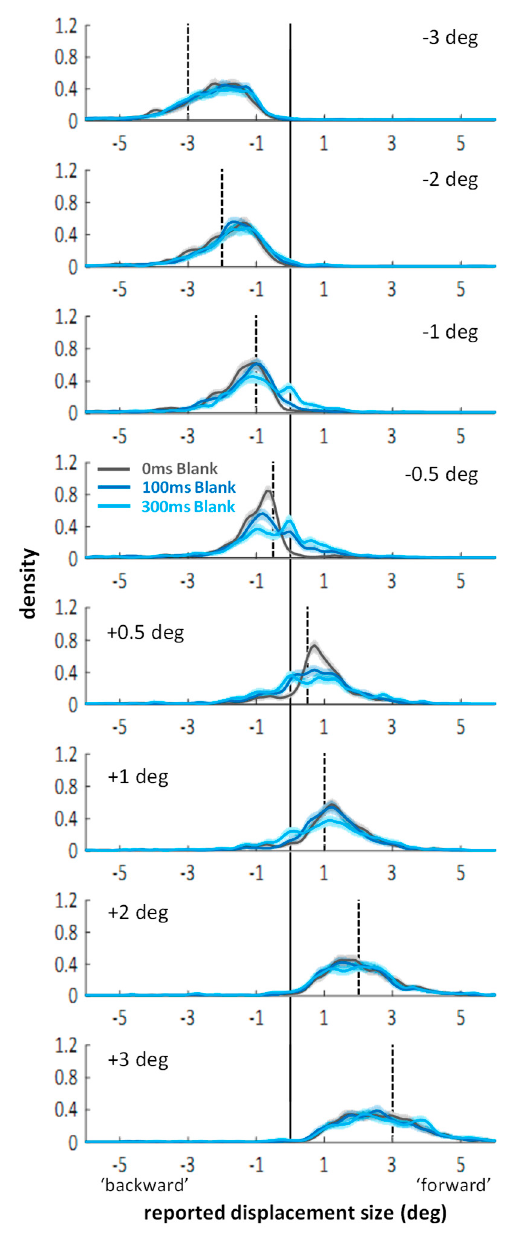
Figure A4. Distribution of responses (kernel density functions) in the three conditions of Experiment 3 (color-coded). Rows represent the different displacement sizes tested. Data are collapsed across all 28 participants. Shadings represent bootstrapped 95% confidence intervals. Vertical black continuous line: zero line. Vertical black dashed lines: actual displacement for each graph. Overall, distributions in the 0 ms blank control condition resembled the ones from Experiment 1 (except that overestimations of smaller displacements seemed somewhat smaller; as for Experiment 1, almost no misses occurred, though). In the 100 and 300 ms blank conditions, some of the smaller ± 0.5 and ± 1 deg displacements were missed. In the 300 ms blank conditions, this is visible in small peaks around zero, while the 100 ms blank conditions rather showed a spread of the distribution towards zero, compared to the no blank condition.